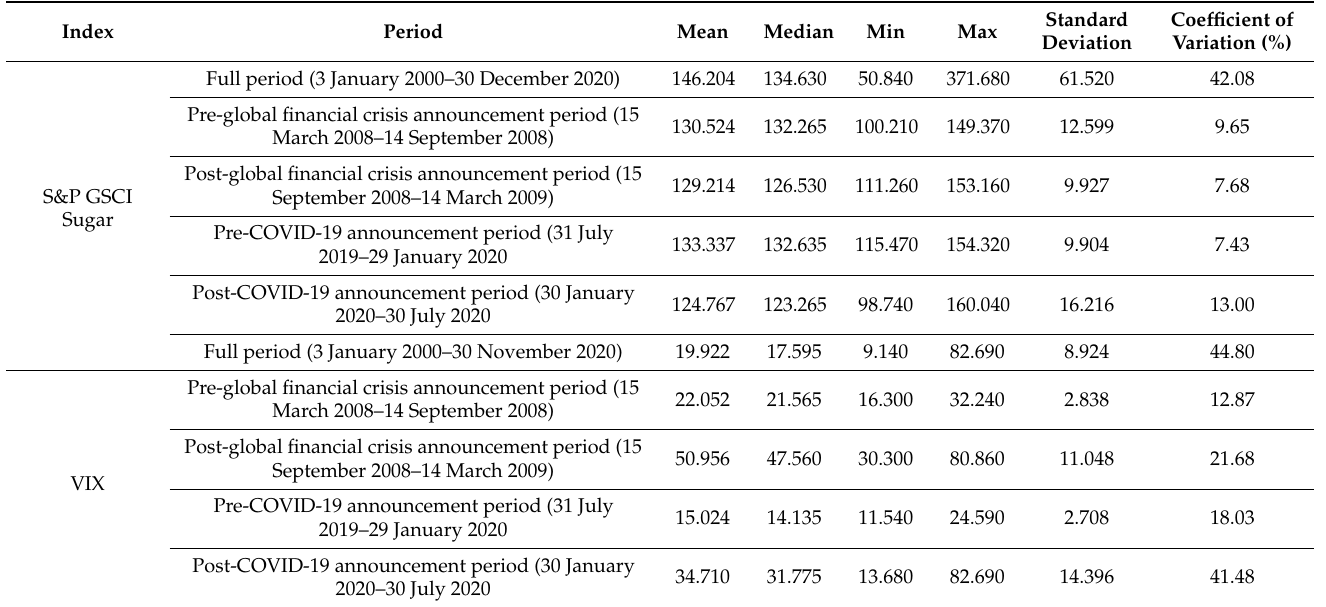
Table 1. Descriptive statistics: S&P Sugar Index and the VIX Index daily data for